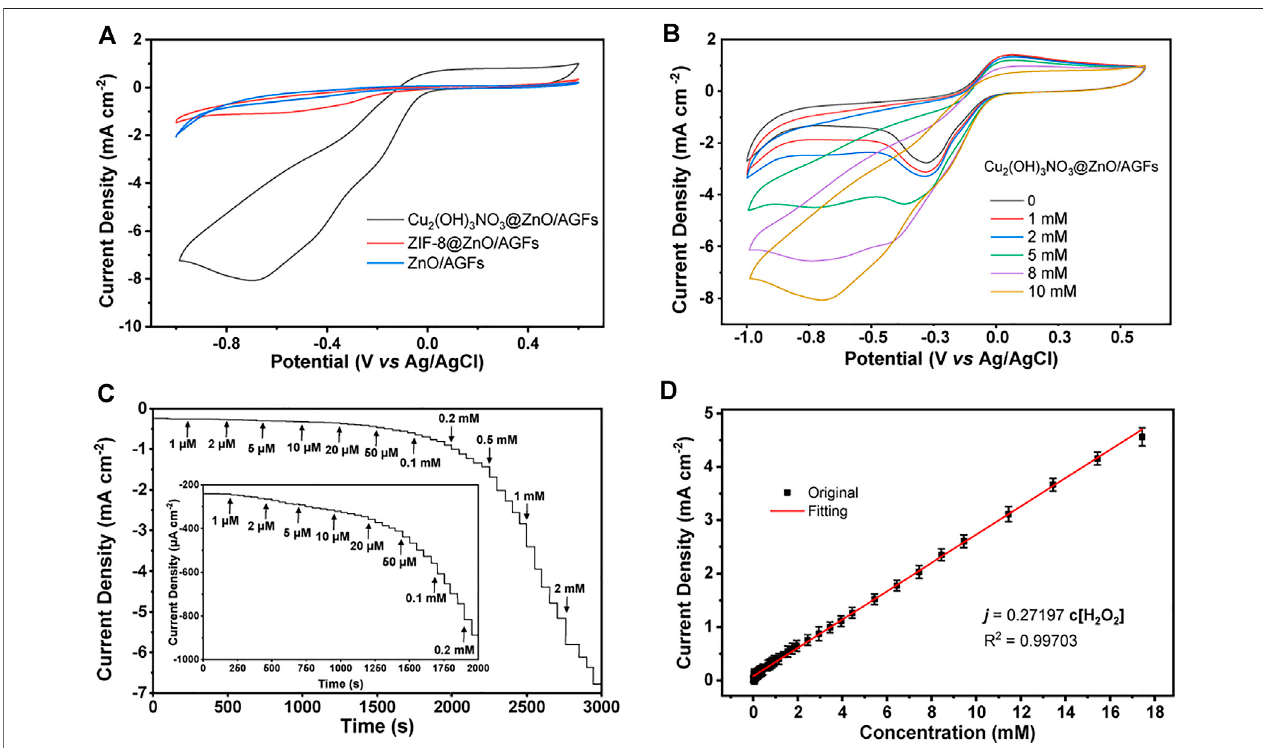
FIGURE 5 | (A) CV curves of ZnO/AGF, ZIF-8@ZnO/AGF, and Cu 2 (OH) 3 NO 3 @ZnO/AGF in 0.1 M PBS solution (pH 7.4) containing 5 mM H 2 O 2 . (B) CV curves of